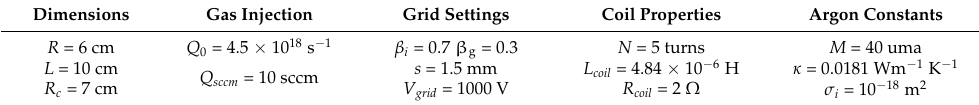
Figure 3. Graphs of the densities of neutral, excited, and charged species in the thruster chamber as a function of RF power. ( a ) Species densities for the complete set of reactions. ( b ) Comparison of common species for the cases 1 and 2. Pressure = 2 mTorr.